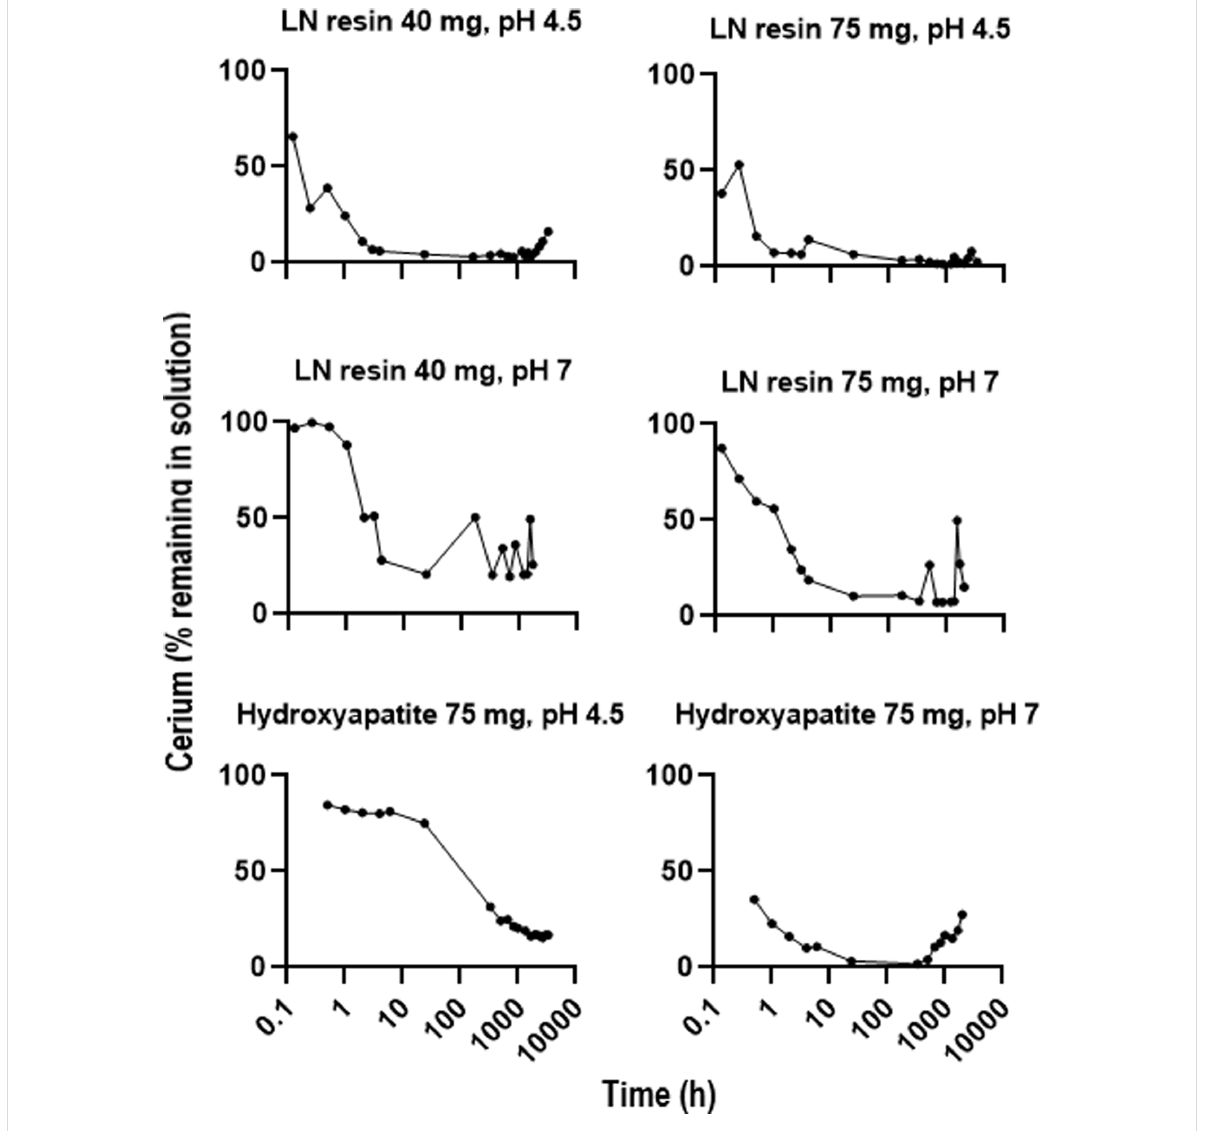
Figure 10: Dependency on the pH value of the complexation of cerium ions with LN resin and HPT. Results are the mean of two observations.